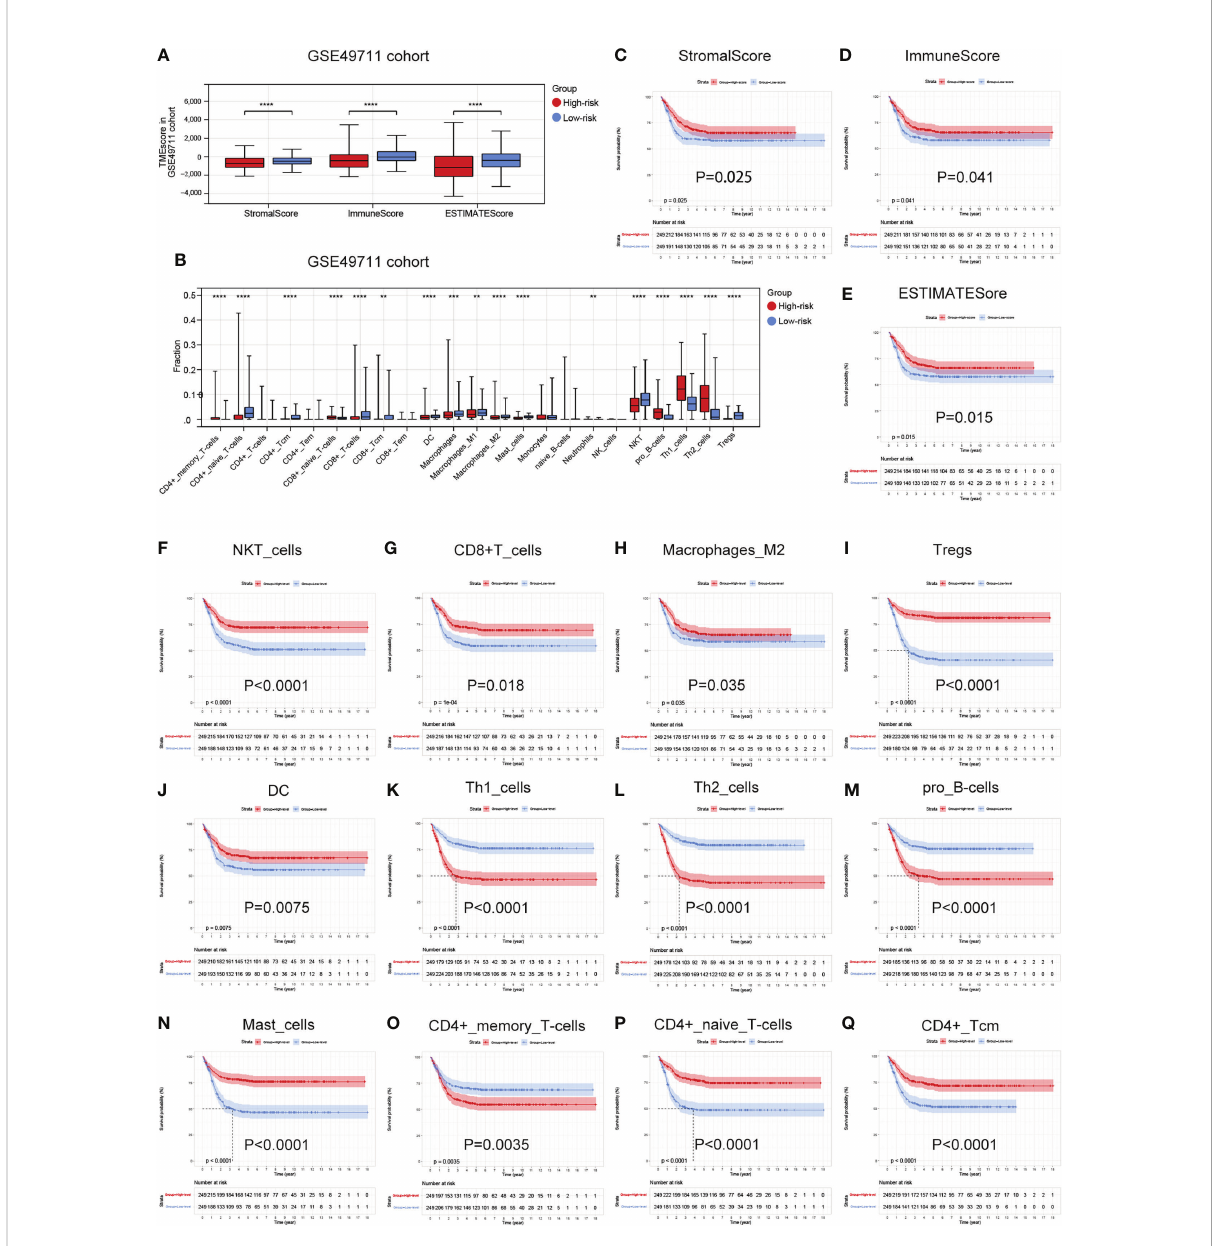
FIGURE 7 Associations between the cuproptosis signature and immune in fi ltration in TME. (A) Estimatescore, Immunescore, and Stromalscore in the two risk subgroups in the GSE49711 cohort. (B) Distribution of 23 types of immune-in fi ltrating cells in the two risk subgroups in the GSE49711 cohort. (C – E) Patients with a lower Estimatescore, Immunescore, or Stromalscore had a worse prognosis in the GSE49711 cohort. (F – Q) Patients with a lower tumor immune cell in fi ltration, that were differentially presented in the high- and low-risk subgroups, had a worse prognosis in the GSE49711